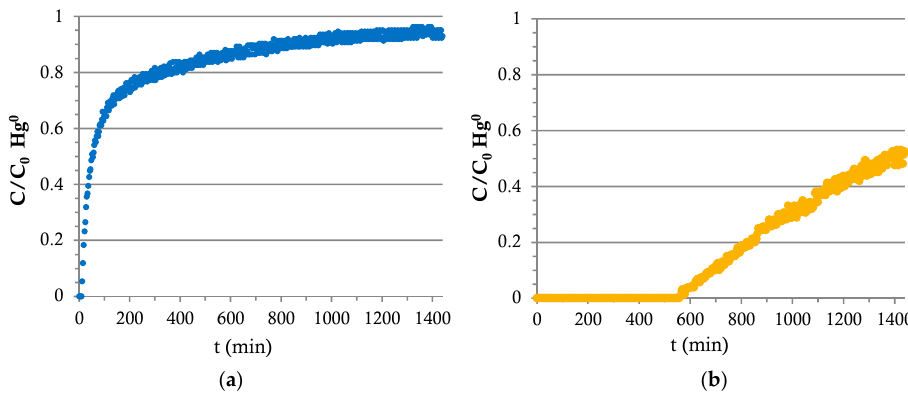
Figure 6. Mercury adsorption curves for: ( a ) CF and ( b ) CF-Au in an atmosphere containing CO 2 and N 2 .